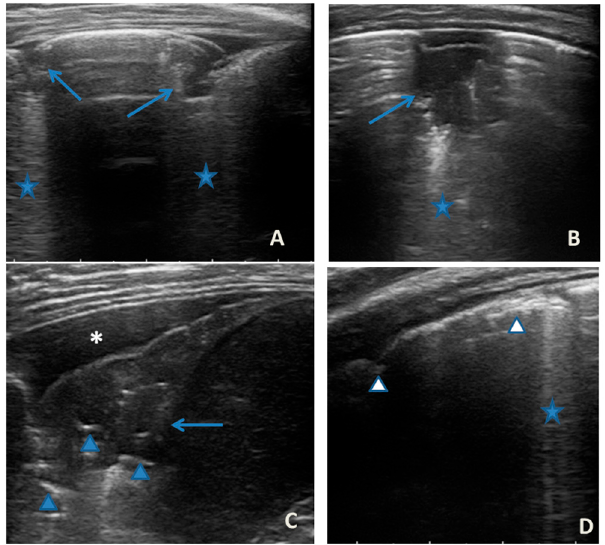
Figure 3. Grayscale lung ultrasound examination shows: an irregular pleural line in all fields explored; on the left anterior-lateral field, mainly in the apical area; ( A ) and on the left anterior retrocardiac field, mainly in the mid-apical area; ( B ) consolidations of an atelectatic nature (arrow), associated with sonographic interstitial syndrome (SIS), represented by coalescent vertical artefacts or B-lines and “white lung” areas (asterisks); ( C ) on the left postero-lateral field in the basal area, consolidation of about 3 cm of atelectasis nature (arrow) with static air bronchograms (punctate) (arrowheads), associated with reactive transudative pleural effusion (white asterisk); ( D ) on the right lateral fields, diffuse sonographic interstitial syndrome (SIS), characterized by irregularities of the pleural line (white arrowheads) and long confluent vertical artifacts